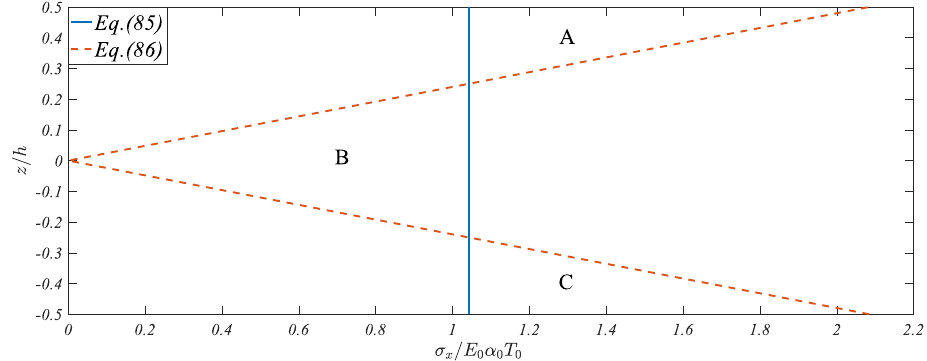
Figure 8. Axial stresses when E + ( z ) = E − ( z ), in which, a 1 = 0, a 2 = 0 and c = 1.